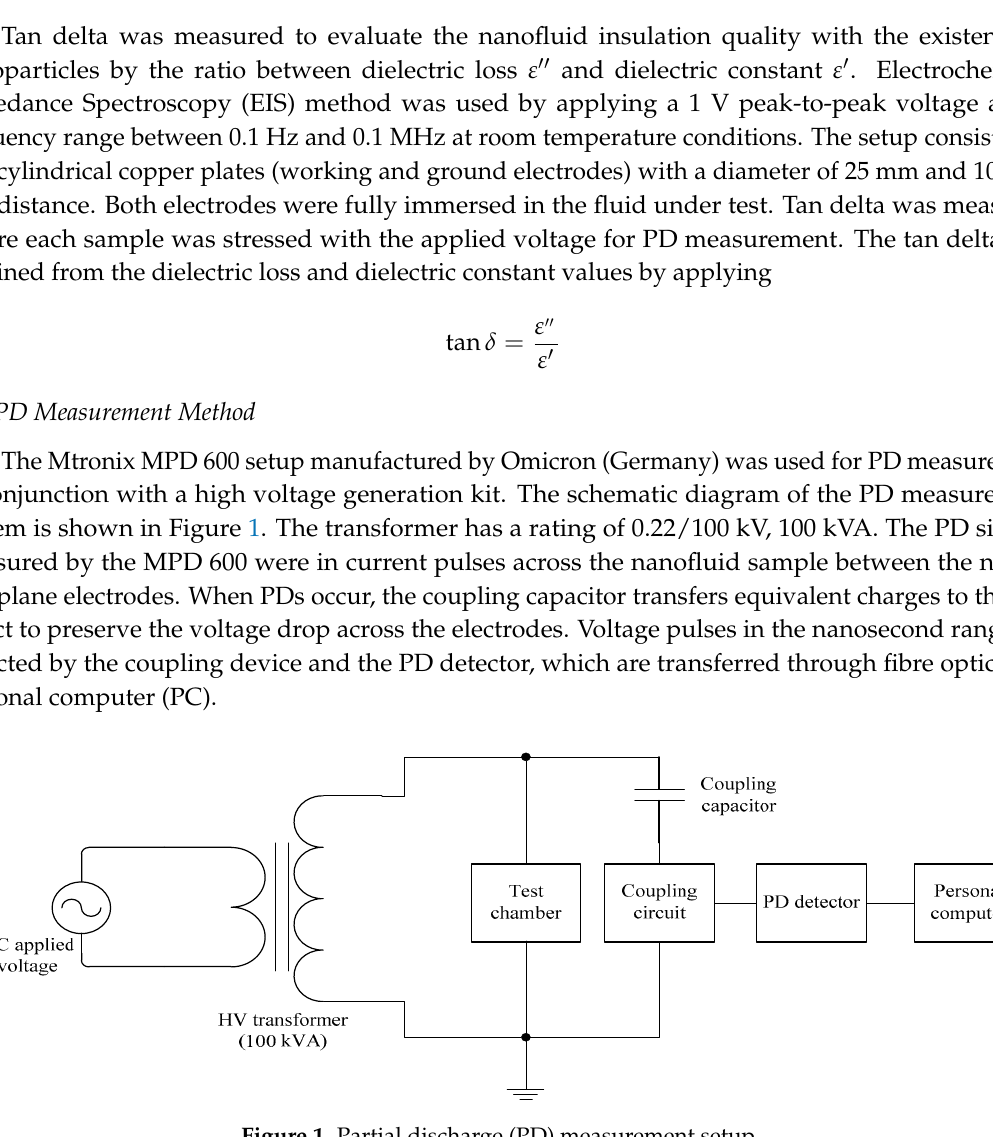
Figure 1. Partial discharge (PD) measurement setup.